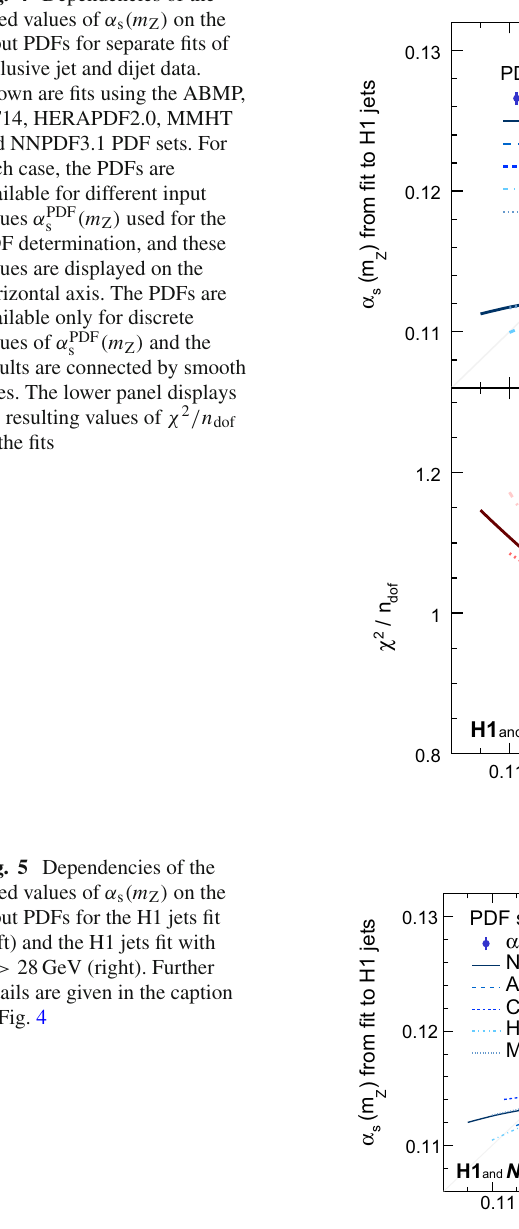
Fig. 5 Dependencies of the fitted values of α s ( m Z ) on the input PDFs for the H1 jets fit (left) and the H1 jets fit with ˜ μ > 28GeV (right). Further details are given in the caption of Fig. 4